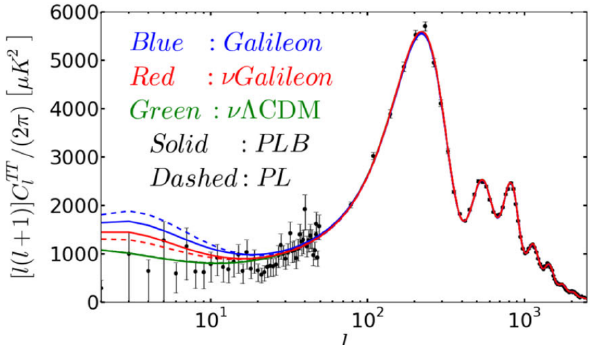
Figure 9. CMB temperature power spectrum. In black dots, data from Planck-2013; in blue, the cubic Galileon model without massive neutrinos; in red, the same model in the presence of massive neutrinos; and in green, baseline Λ CDM with standard neutrino mass. The difference between solid and dashed lines corresponds to an analysis of Planck with and without BAO data,